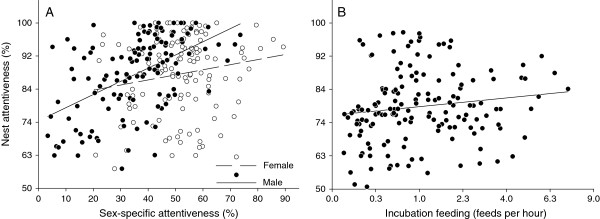
Relationship between total nest attentiveness (squared) and A) male and female nest attentiveness, and B) incubation feeding (square-root transformed) in species with biparental incubation (N = 124) and male incubation feeding (N = 156), respectively. Points are species averages and fitted lines are ordinary linear regressions for illustrative purposes only.